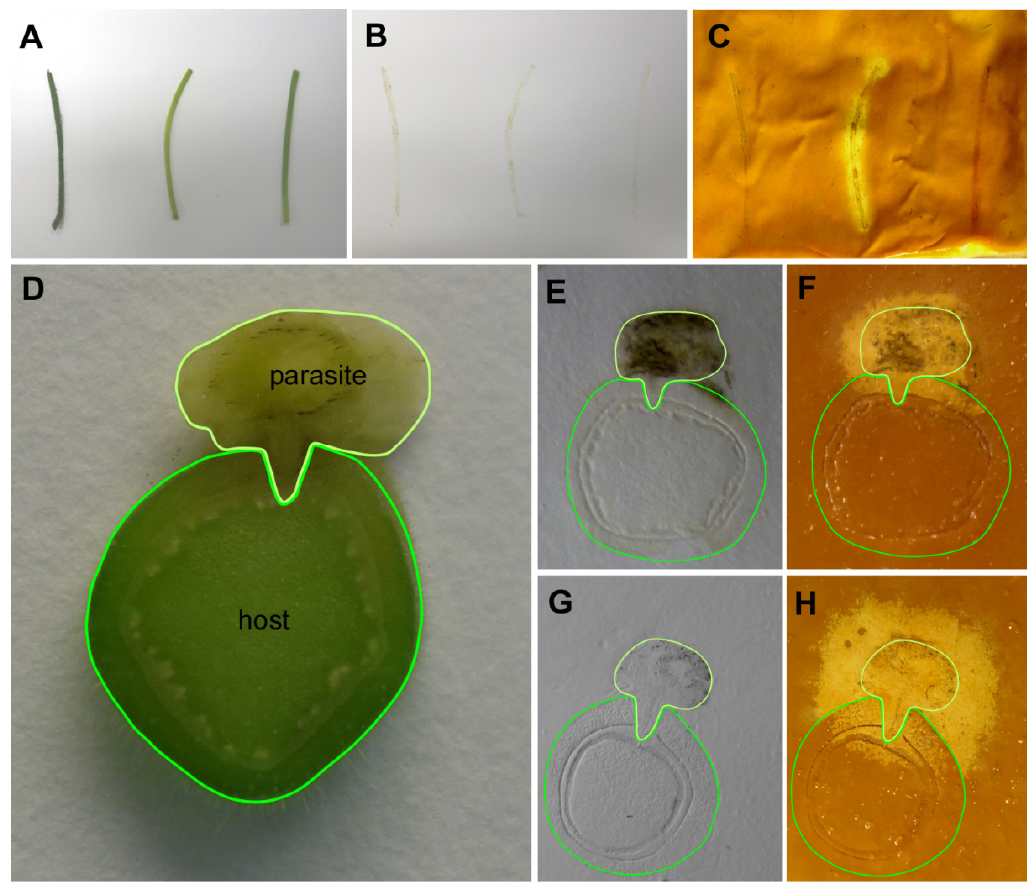
Figure 3. Gram’s iodine detection of cellulase activity in tissue prints covered with a layer of gelatinous CMC. ( A – C ) Cellulase activity in longitudinal sections prepared from stems of (from left) Solanum lycopersicum , Cuscuta reflexa and Pelargonium zonale ; and ( D – H ) Localization of cellulase activity in cross-sections of parasitic plant infection sites. For ease of reference host and parasite (including the haustorium penetrating into the host) have been encircled with dark green and light green lines, respectively; ( A , D ) plant material as printed; ( B , E , G ) tissue prints on dry nylon membrane; and ( C , F , H ) zymograms after coating with 4% CMC and Gram’s iodine